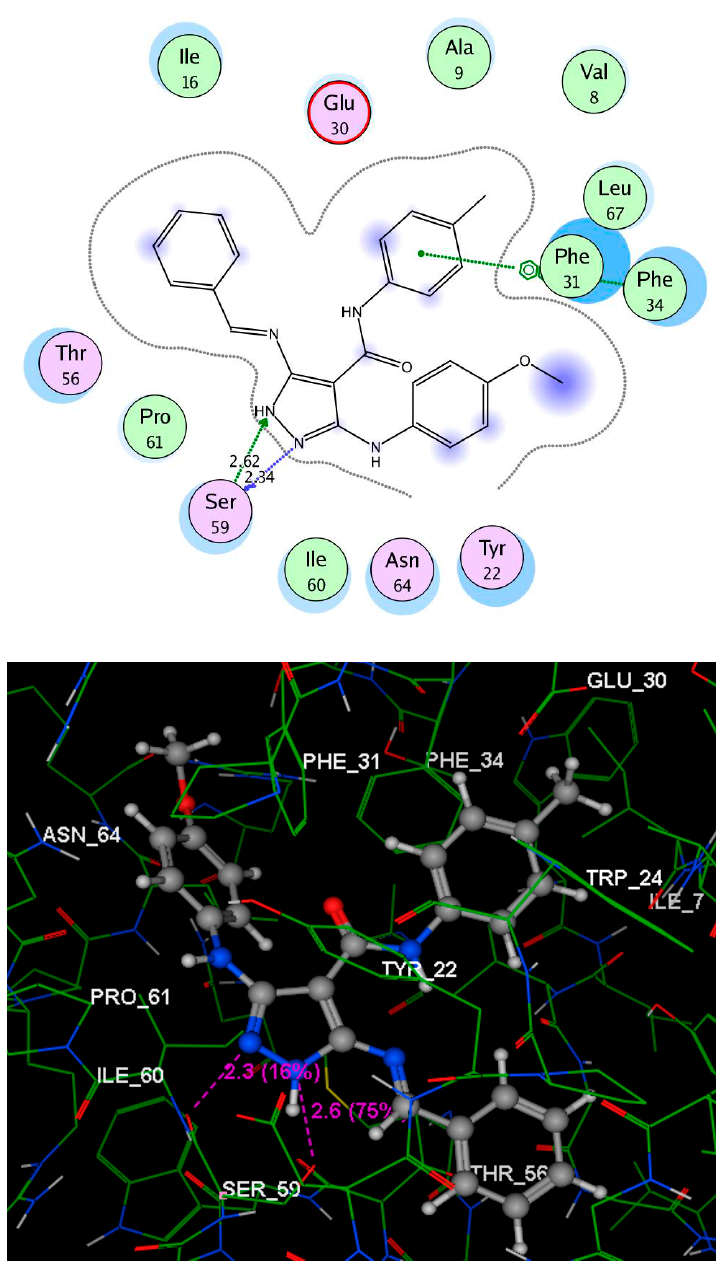
Figure 5. 2D and 3D interaction diagrams of compound 18 with DHFR (PDB code: 1DLS) (hydrogen bonds are illustrated as arrows, C atoms are colored gray, N blue, and O red).